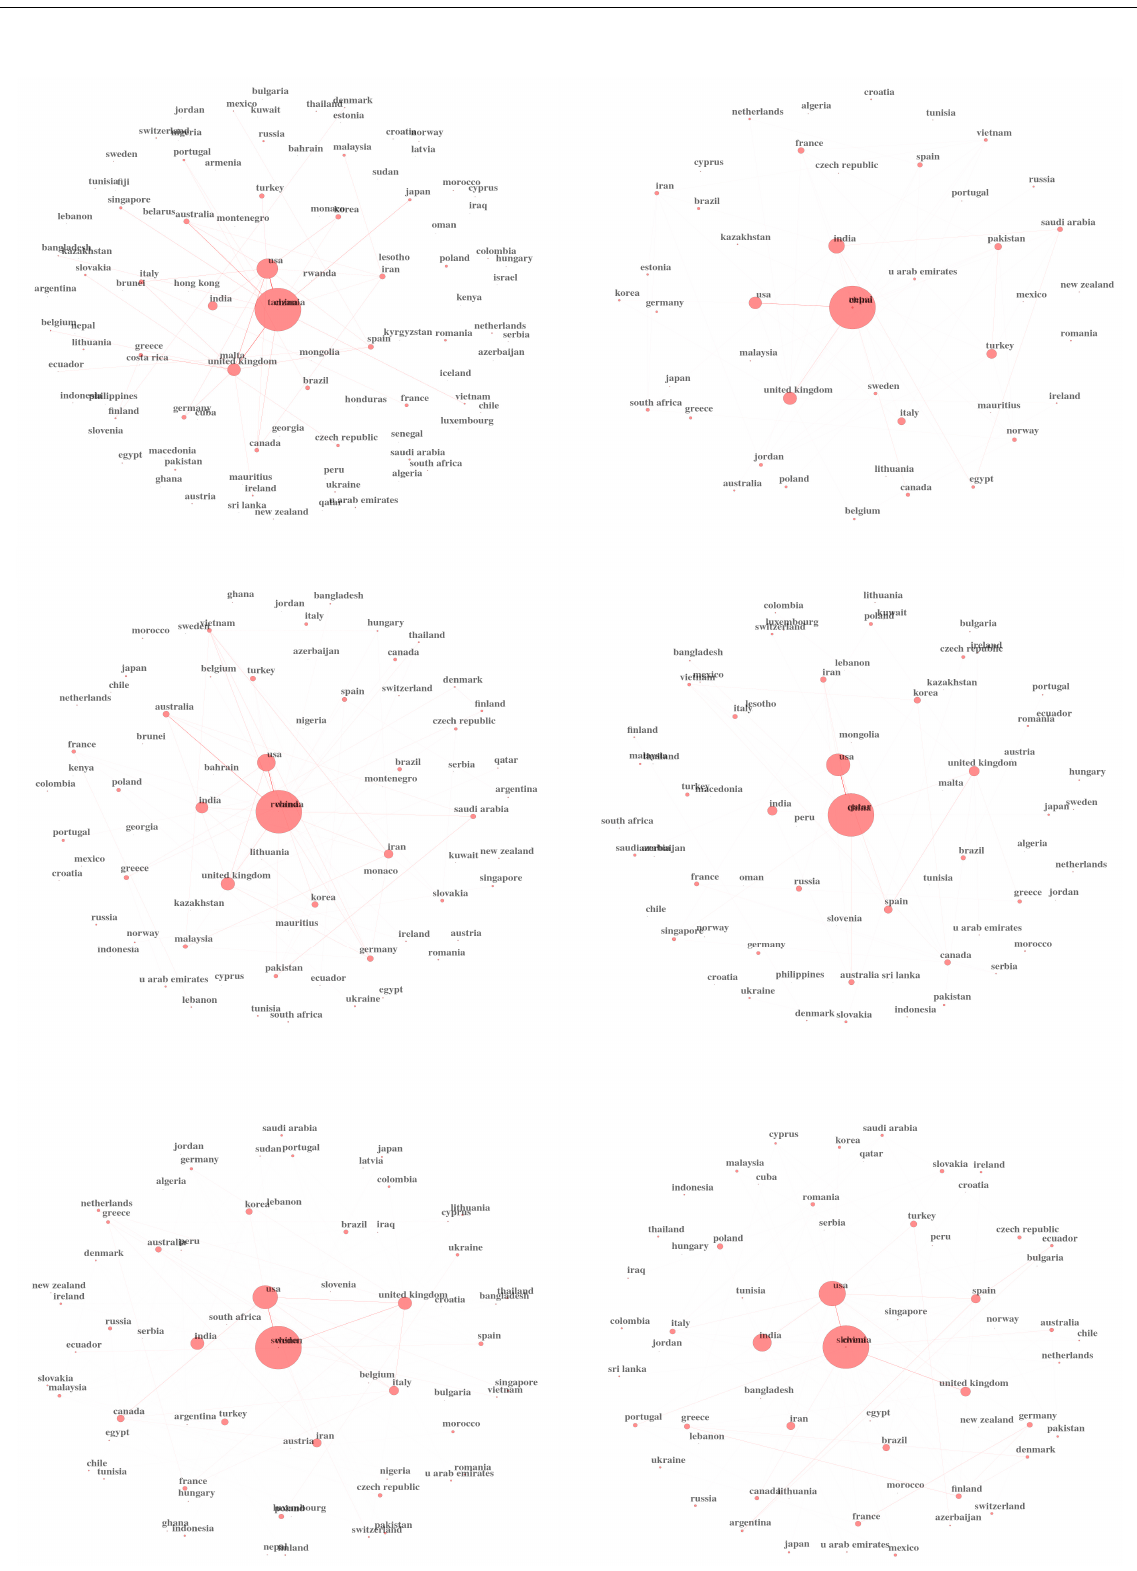
Figure 13. Country collaboration networks, overall period, and per year.